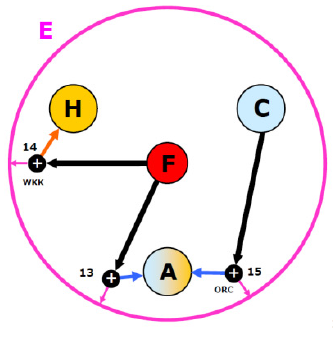
Fig. 6. – Positive thermodynamic